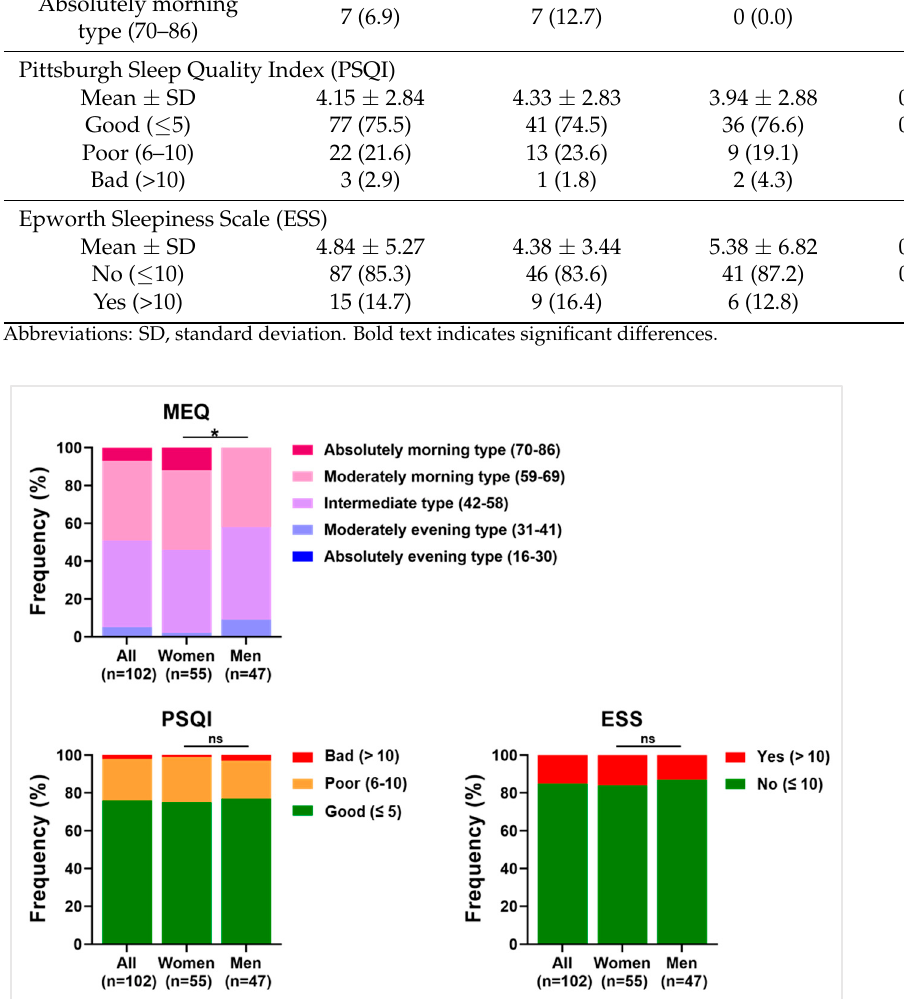
Figure 4. Distribution of relative percentage frequencies within nurses in sleep-related questionnaires. The plots show the percentage distribution of the nurses for the whole population (left columns), as well as when stratified into women (middle columns) and men (right columns) within the three scales relative to work-related sleep quality: Morning Evening Questionnaire (MEQ), Pittsburgh Sleep Quality Index (PSQI), and Epworth Sleepiness Scale (ESS). In MEQ, burgundy indicates morning type, the purple shades indicate intermediate types, and blue indicates evening types. In PSQI and ESS, green indicates positive outcomes, orange indicates intermediate outcomes, and red shows negative outcomes. * p < 0.05; ns, not signi fi cant.